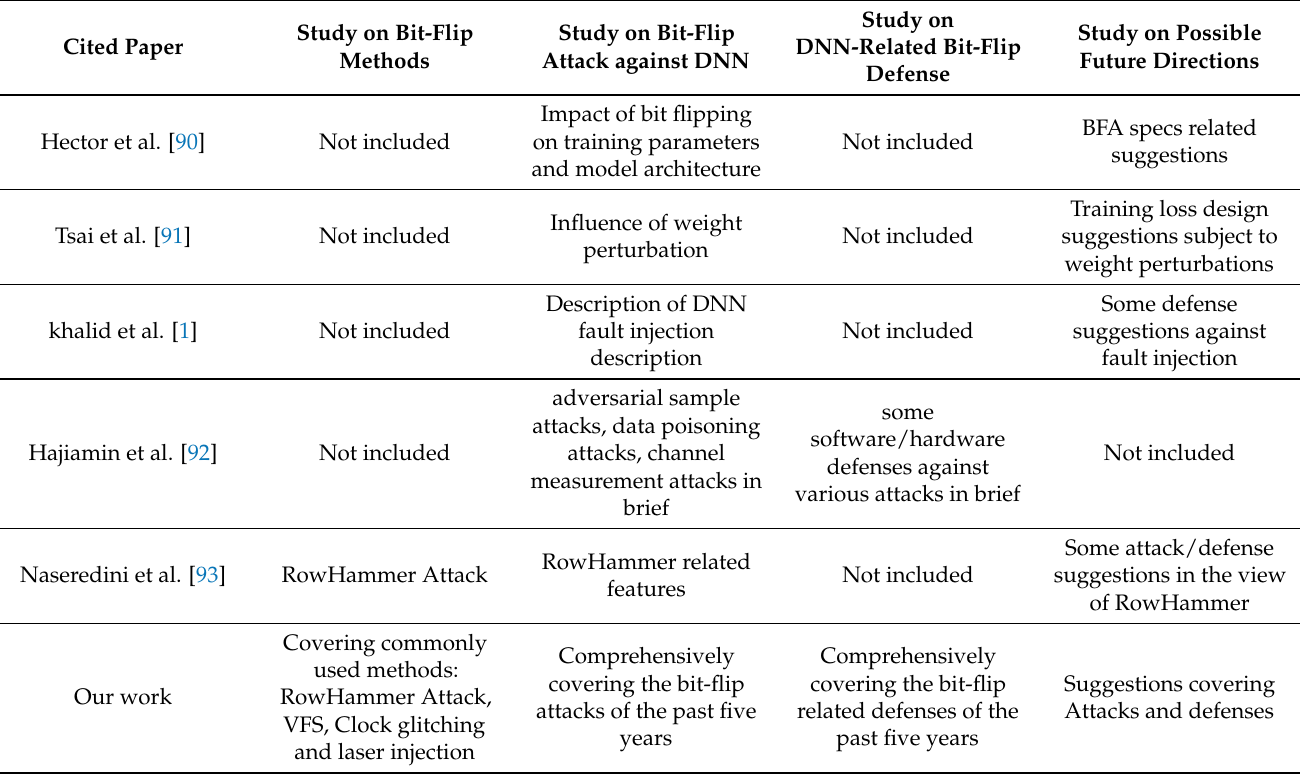
Table 12. Comparisons between the related works and our